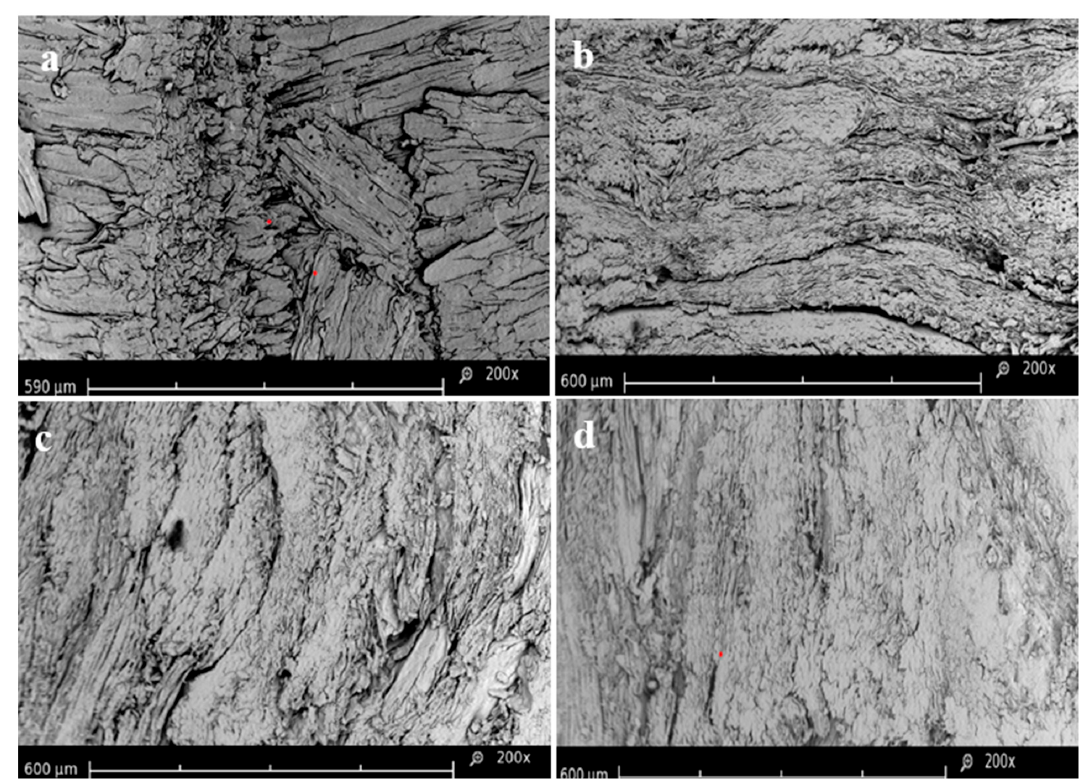
Figure 10. SEM micrographs images of WSS pellets: ( a ) un-torrefied WSS; ( b ) WSS torrefied at 200 °C; ( c ) WSS torrefied at 250 °C; ( d ) WSS torrefied at 300 °C.